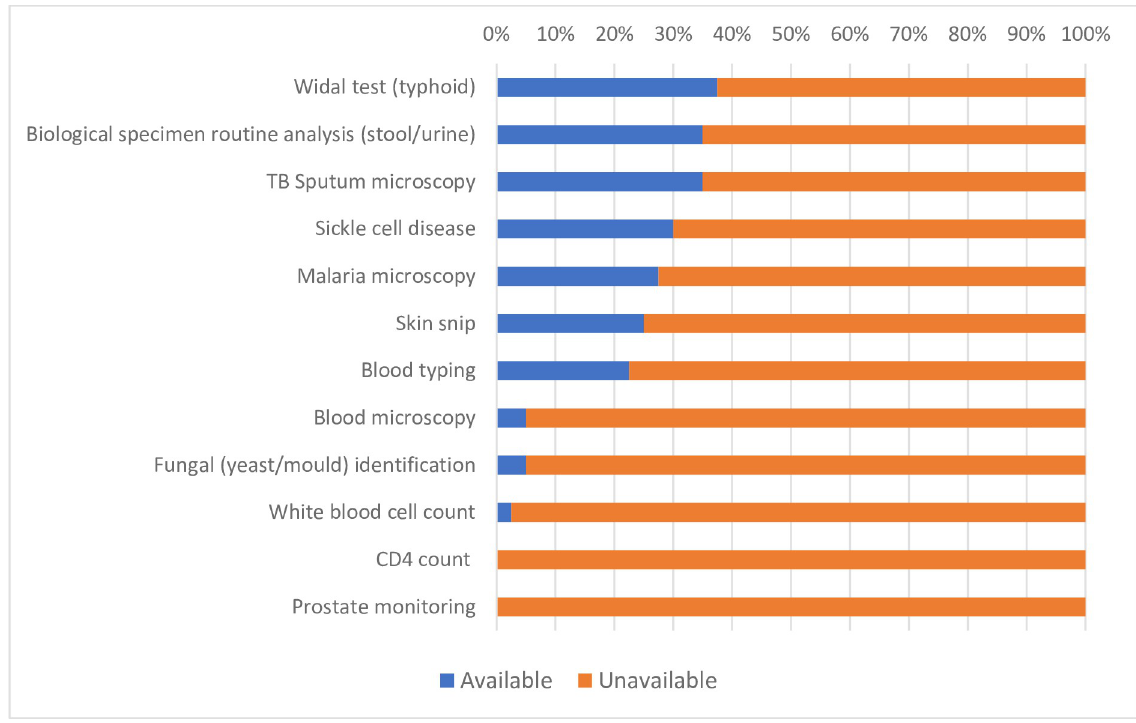
Fig 2. Availability of assay-based